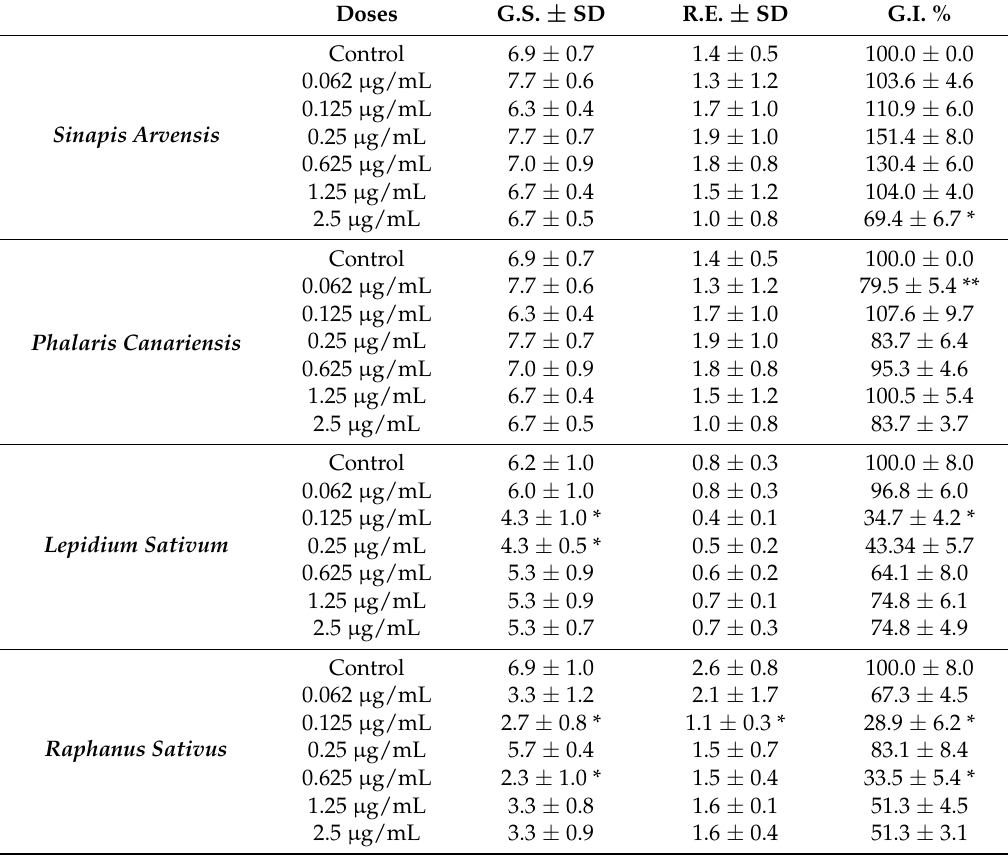
Table 5. Phytotoxic activity of oregano EO against seed germination and radical elongation (cm). Data of seed germination are expressed in number, radical elongation are expressed in cm and germination index are expressed as